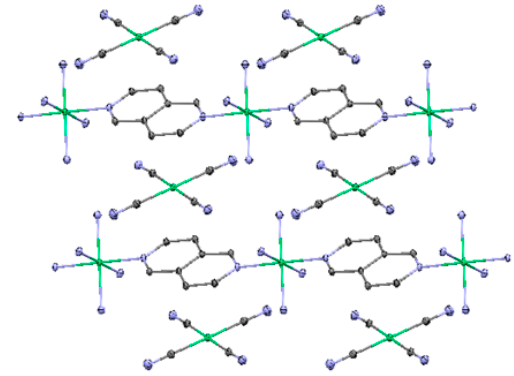
Figure 21. The Ni-Naph structure showing 1-D chains of Ni(Naph)(NH 3 ) 4 and individual units Figure. 21.